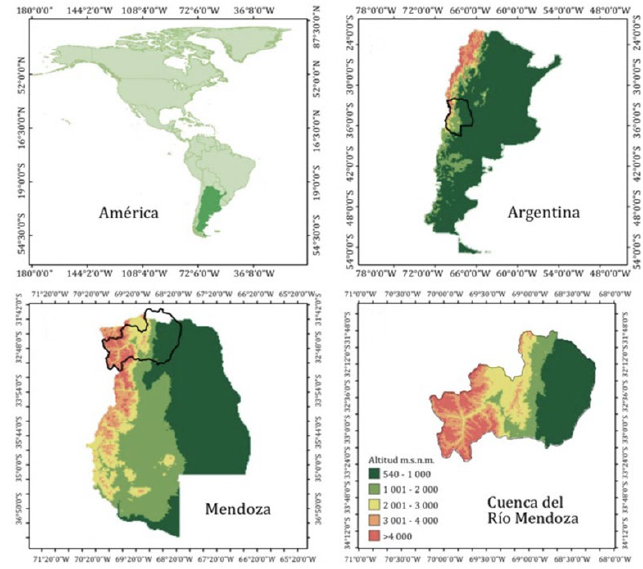
Figure 2. Location of Mendoza’s river basin (Northern Oasis) [32].